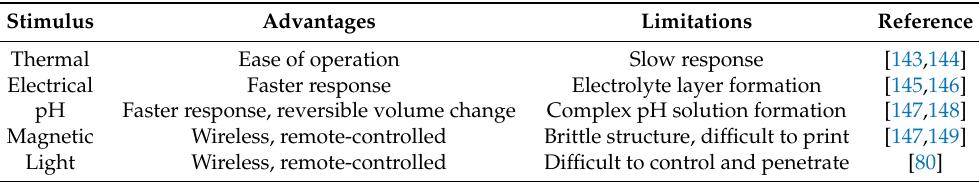
Table 3. Advantages and limitations of hydrogel-based soft actuators for different stimuli. Adapted with permission from [142]. Copyright 2016,